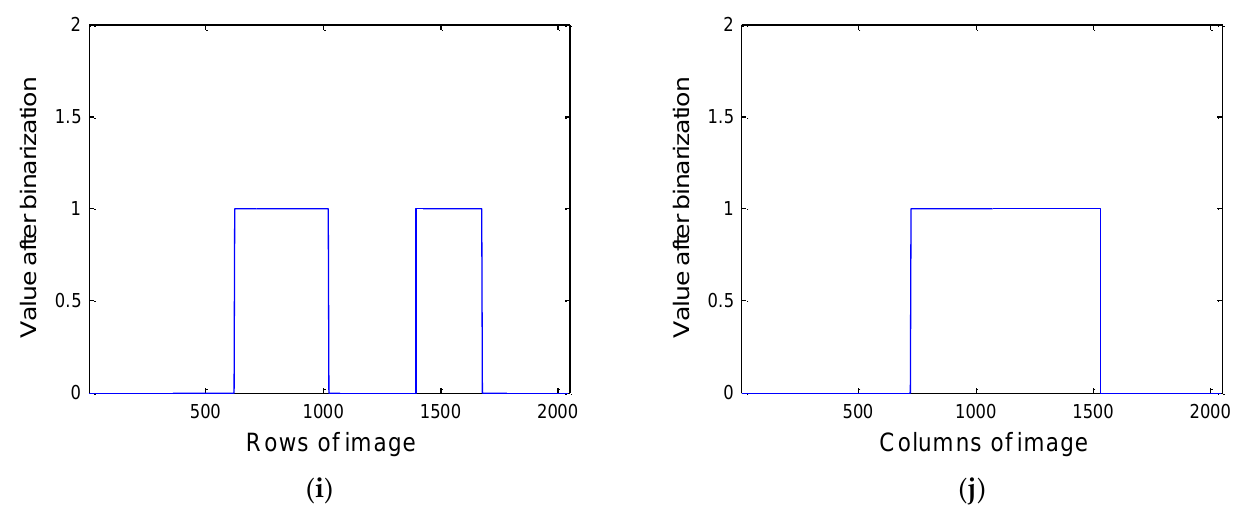
Figure 8. Partition operation for the IOI. ( a ) Image of interest (IOI). ( b ) Partition results. ( c ) HM 1 ( u ) curve. ( d ) VD 1 ( v ) curve. ( e ) HM 1 ′ ( u ) curve. ( f ) VD 1 ′ ( v ) curve. ( g ) B HM1 ( u ) curve. ( h ) B VD1 ( v ) curve. ( i ) B HM1 ′ ( u ) curve. ( j ) B VD1 ′ ( v ) curve.